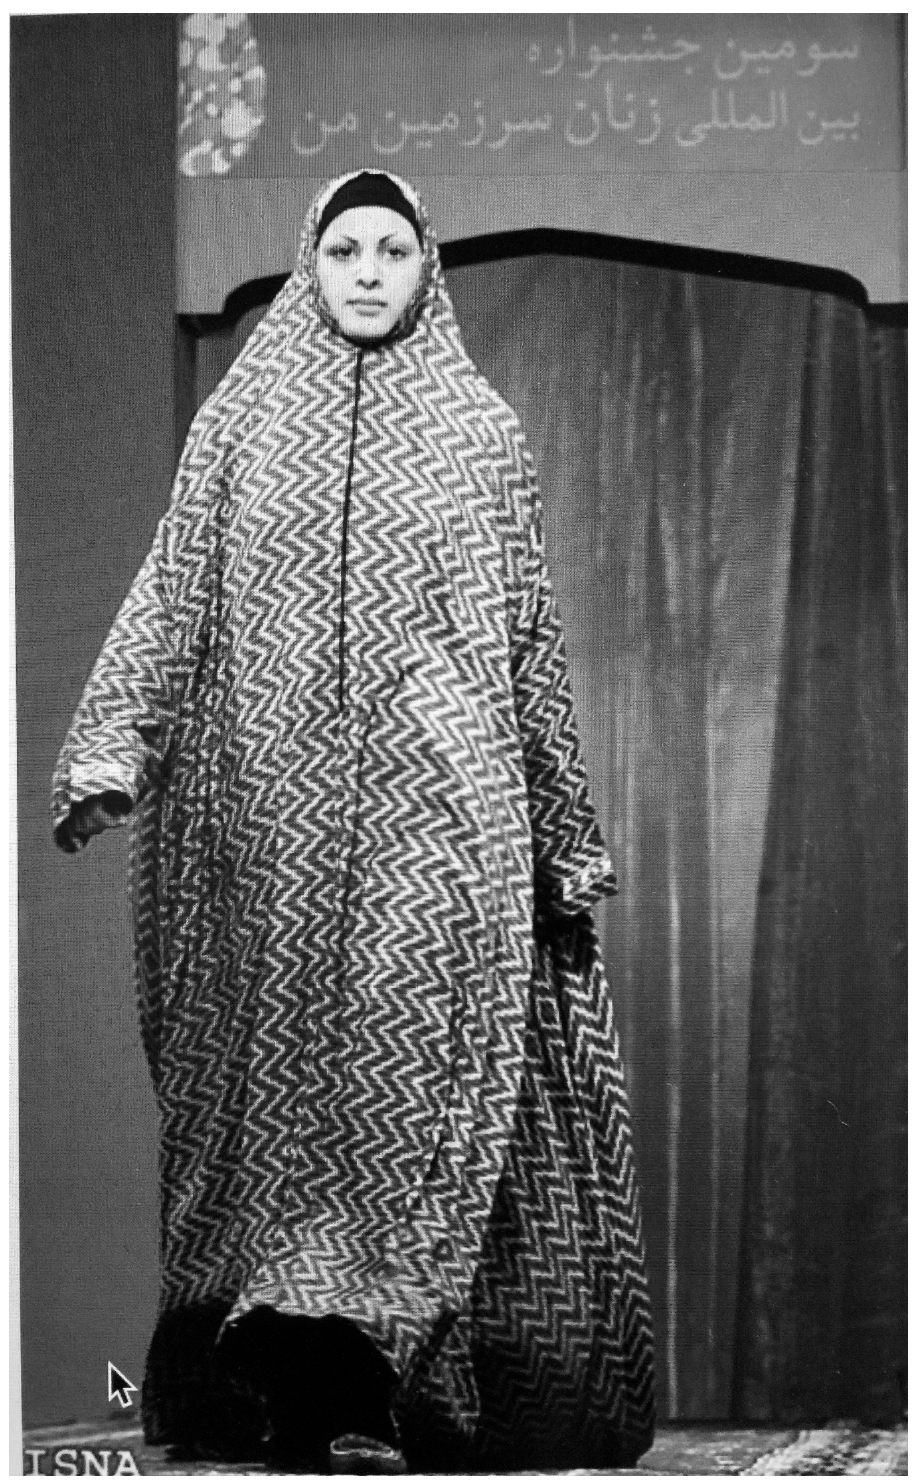
Figure 11. This fashion was presented at the “3rd International Festival of Women of My Land.” organized in 2008. The garment basically is a zip up loose version of the Arabian Abbaya with herringbone design in white and gray pattern. These earlier governmental organized fashion festivals did not have any innovativeness in design or colorful fabrics. That was the main reason for such garments not selling. Iranian women did not care to look like anything as the model presenting. Source: http://www.payvand.com/news/08/jul/1192.html ISNA/ Photo credit: Homa Hoobehfekr.